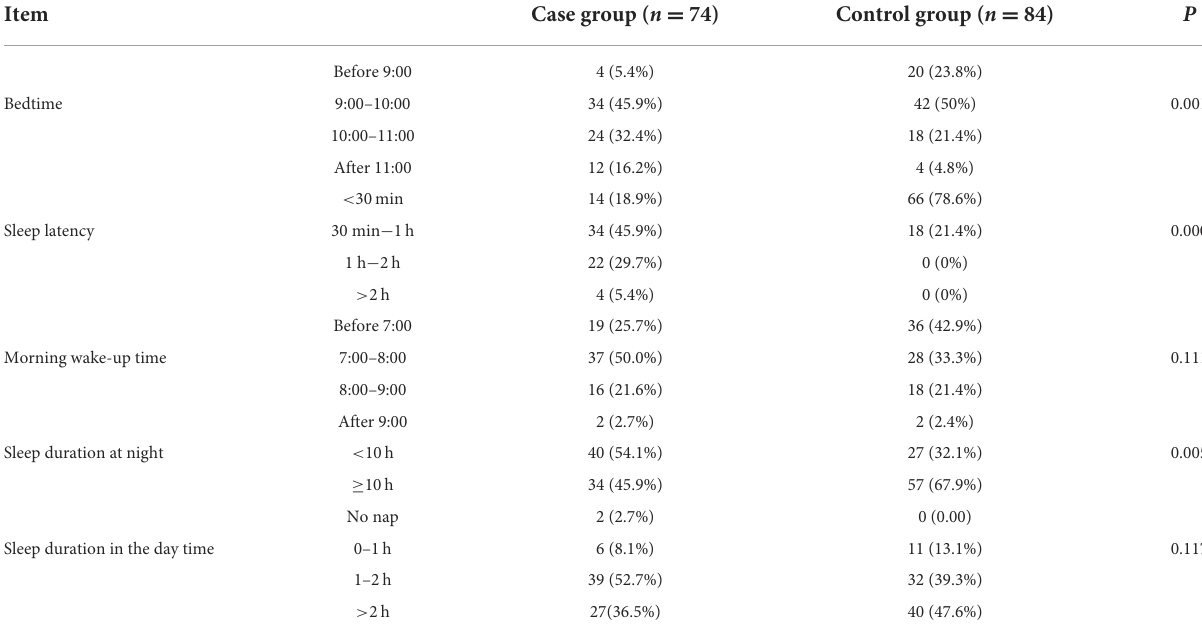
TABLE 3 Comparison of sleep status between case group and control group.